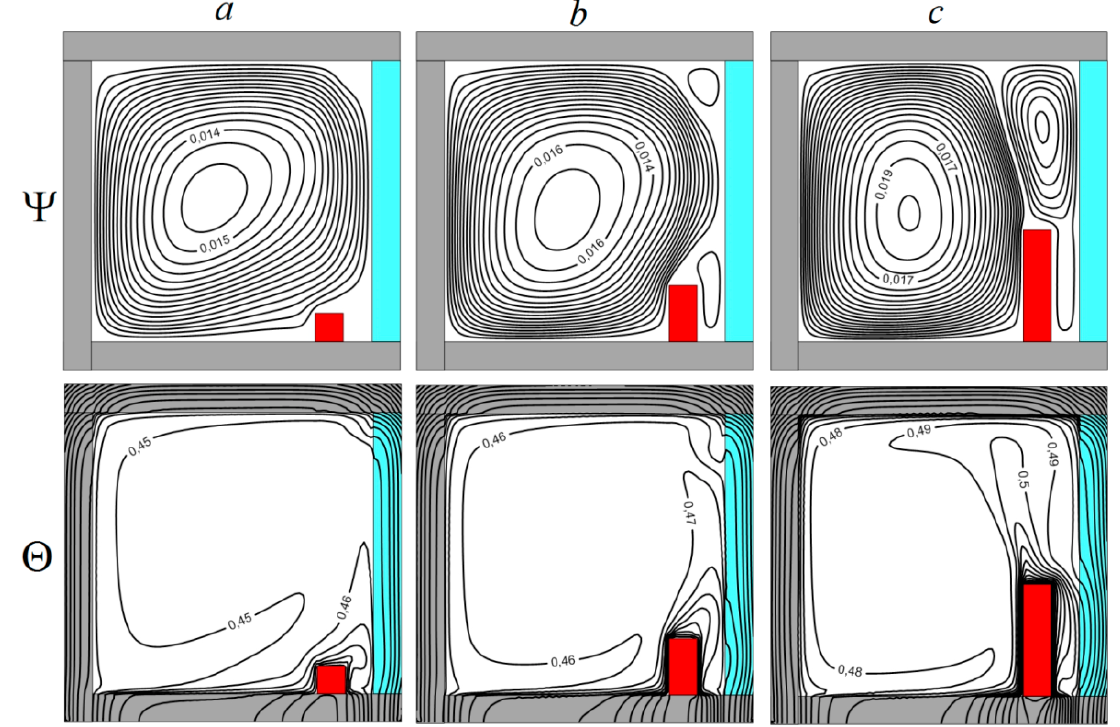
Figure 4. Streamlines Ψ and isotherms Θ for various values of heater height l at ε h = 0.5: l/L = 0.1—( a ), l/L = 0.2—( b ), l/L = 0.1—( c ).